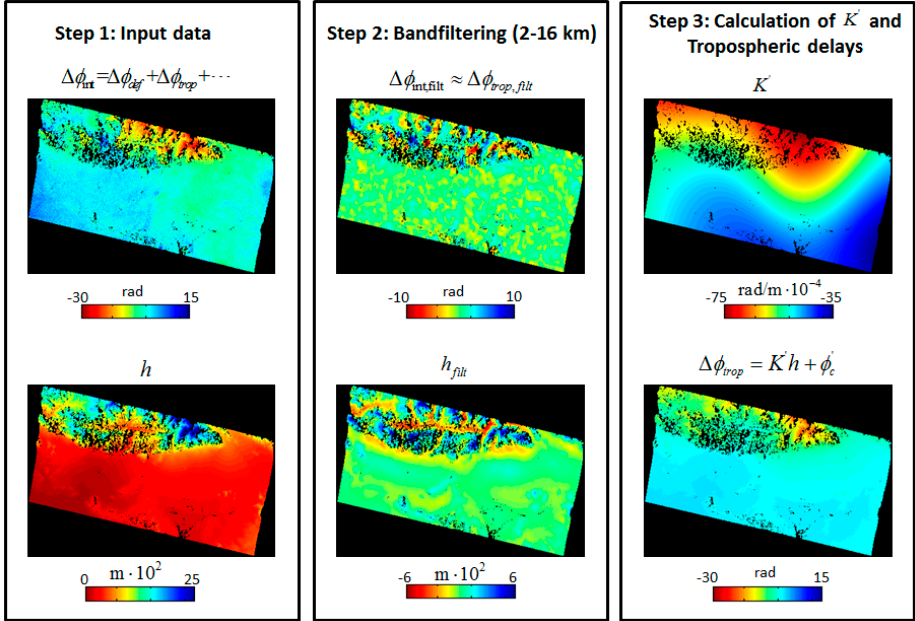
Figure 2. Tropospheric delay estimated using the RMW method for the interferogram created from images collected on 12 July 2008 and 18 April 2009. Step 1: the original interferometric phase ∆ φ int above and the elevation h below were derived from the SRTM DEM. Step 2: the band filtering in the 2–16 km spatial wavelength. Step 3: a spatial map of K 1 was acquired after local robust estimation for each block and subsequent extrapolation using multi-weights for all PS points. The final tropospheric delays (Step 3, lower figure) were obtained using the rewritten linear model (Equation (3)).